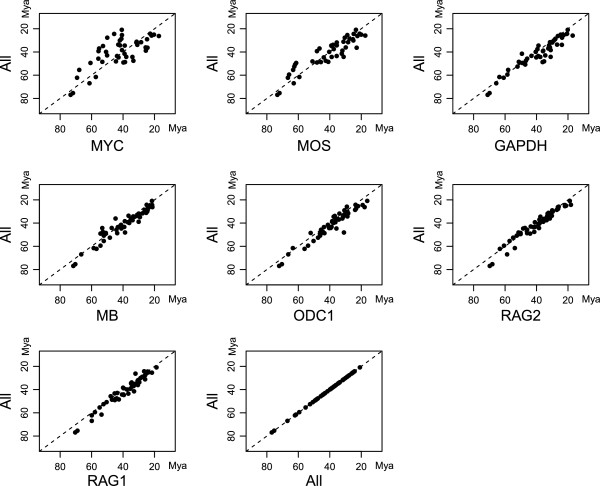
Median divergence-time estimates from individual genes (x axes) versus the combined data (y axes, “All”) for corresponding nodes in the tree from the analysis of the combined data. The dotted line represents the one-to-one correlation. Genes are ordered from left to right and top-down by the number of parsimony-informative characters. The last, trivial, correlation (All vs. All) is included to illustrate the concentration of node estimates over time.